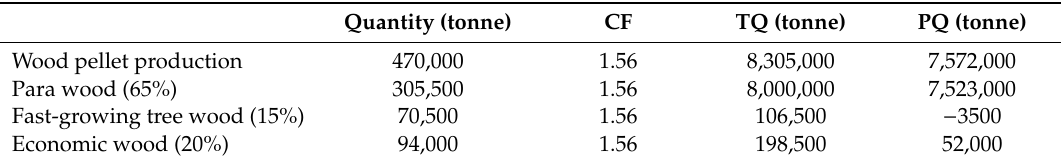
Table 7. The potential of feedstock for 470,000 tonnes of wood pellets ( + 25% of wood pellet export and + 50% of wood pellet domestic